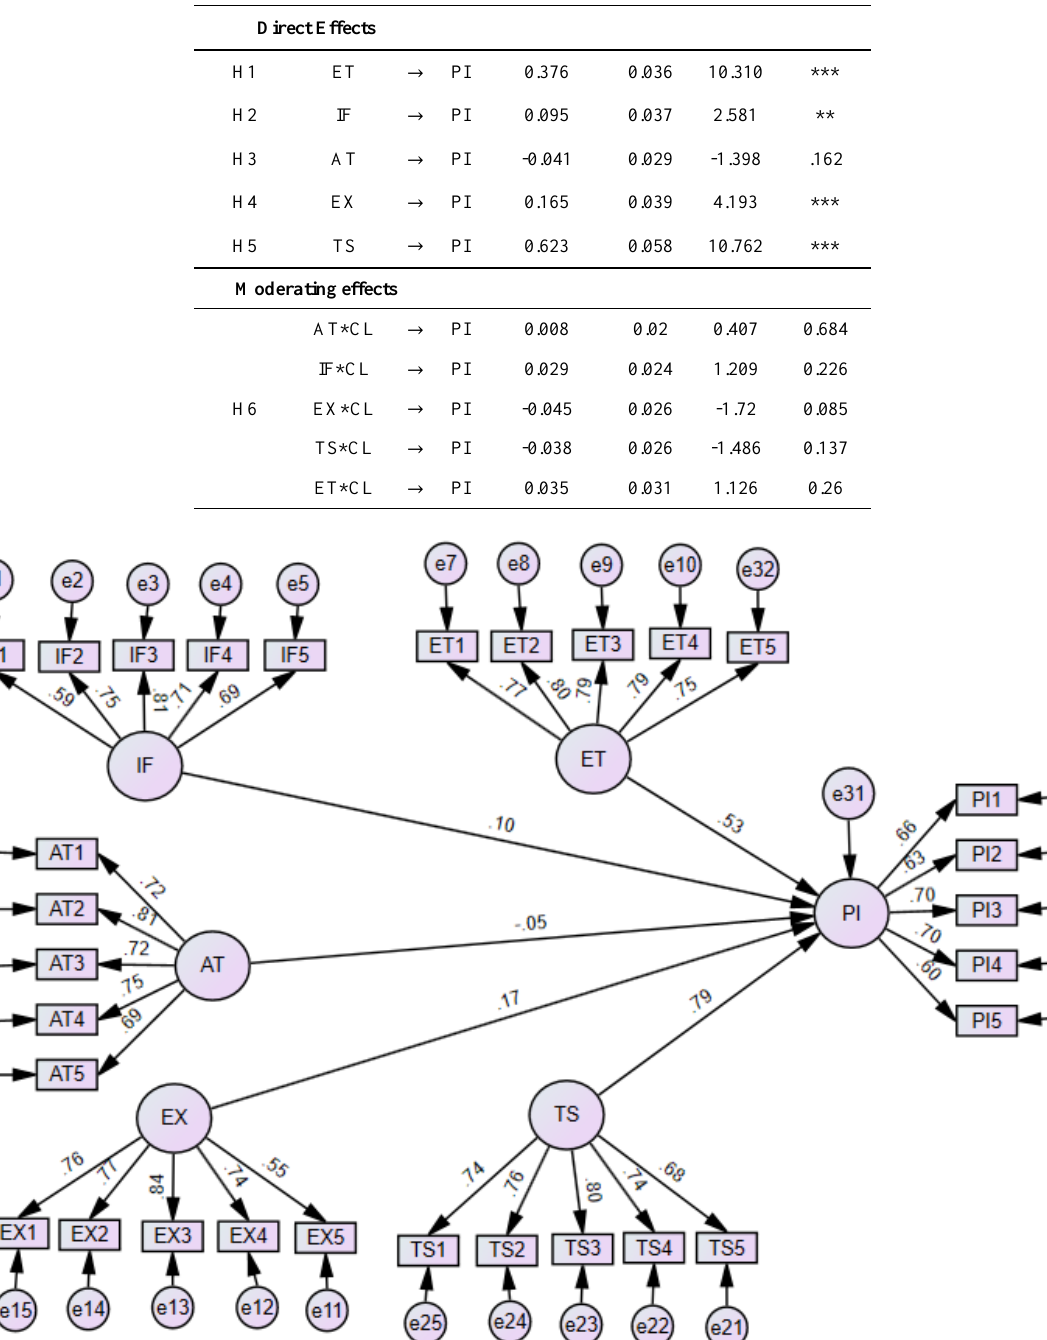
Table 5. Hypothesis Evaluation and SEM Analysis